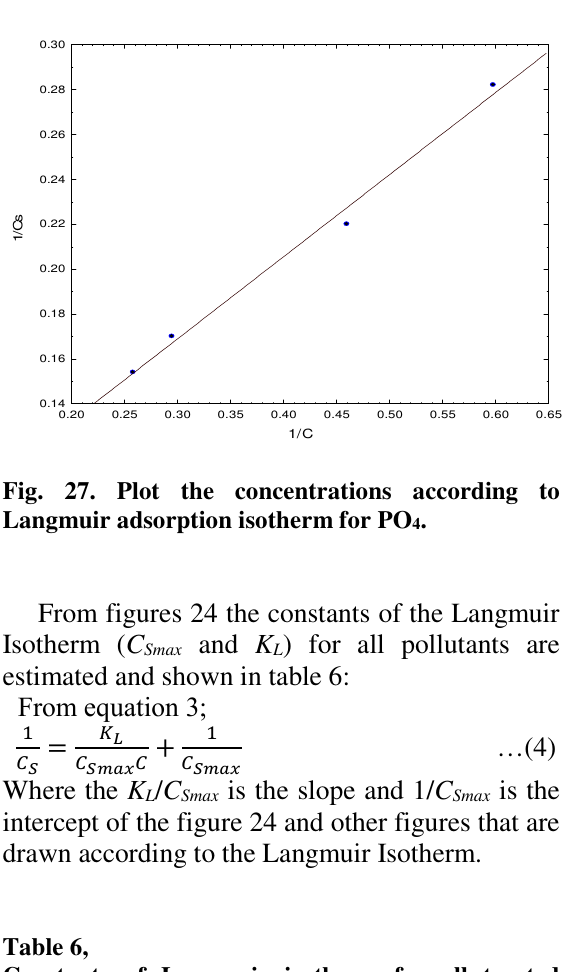
Fig. 26. plot the concentrations according to Langmuir adsorption isotherm for NO 3 .